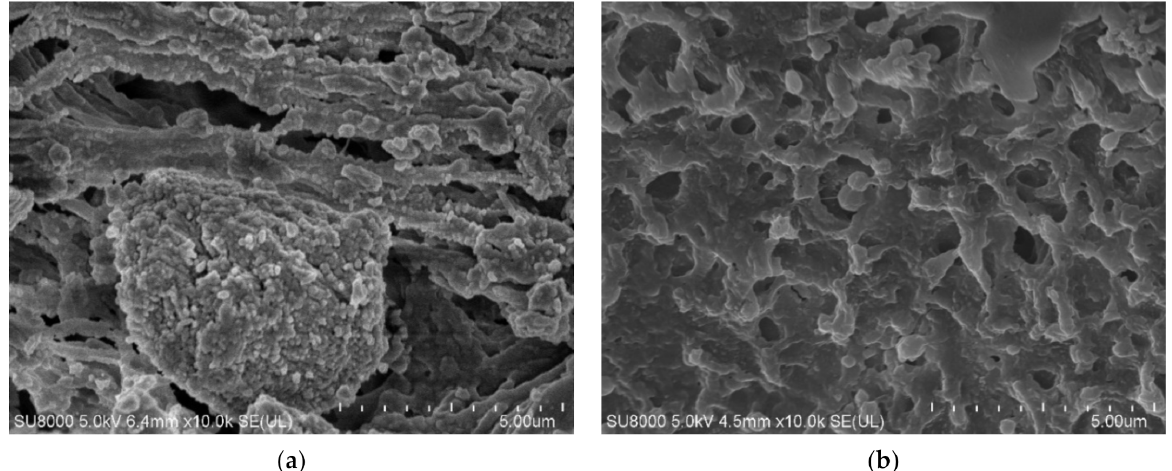
Figure 17. SEM images of membrane surface covered by deposit precipitated from OWW1 wastewa- ter: ( a ) Module M4, T F = 343 K; ( b ) Module M5, T F = 333